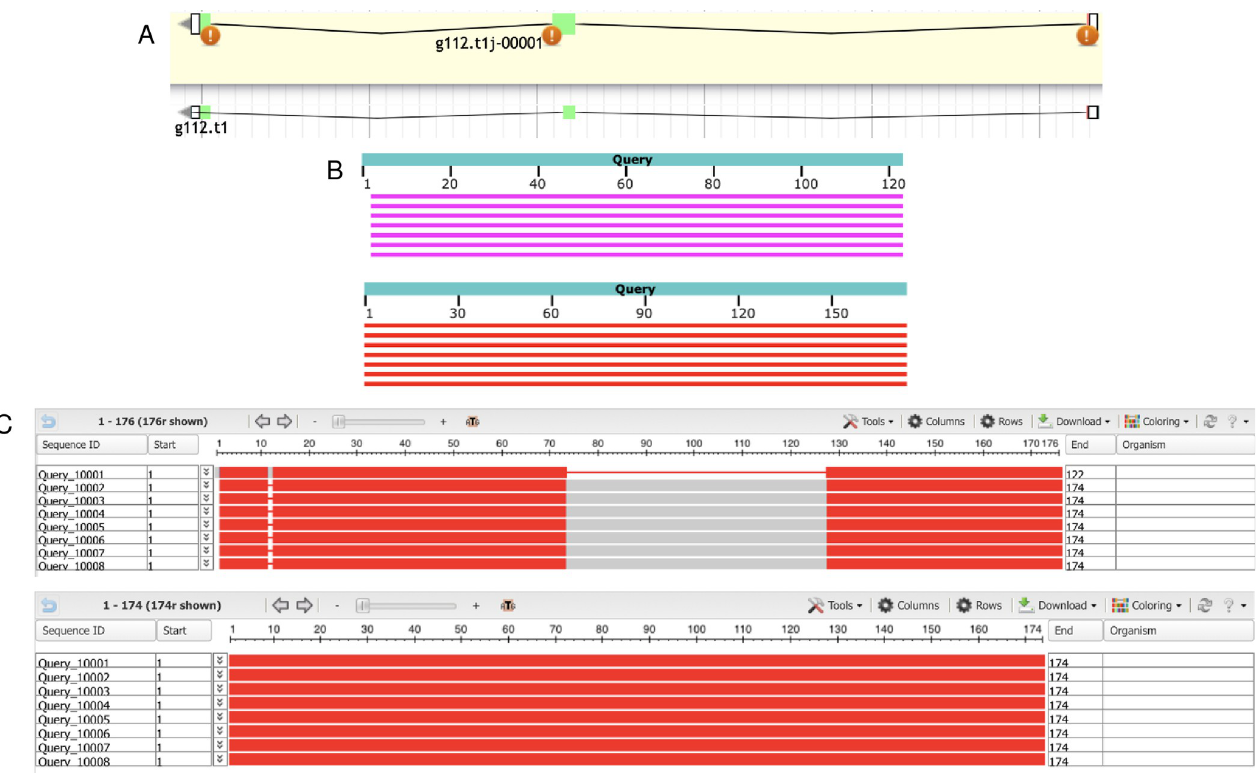
Fig 5. Homology-based genome annotation of the methylmalonyl-CoA epimerase (MCEE) enzyme. (A) Apollo gene editor view and AUGUSTUS track of the g112.t1 gene located within the ML679947.1 scaffold. Bottom: initial ab initio prediction. Top: consensus gene model. (B) Graphical representation of query coverage across the top 7 BLAST hits on 7 subject sequences before (top) and after (bottom) genome editing. Red means high conservation, and magenta means moderate conservation. (C) COBALT multiple sequence alignment before (top) and after (bottom) genome editing, demonstrating high conservation (red) across the homologs. Low conservation is colored gray. Exons (thick lines) and introns (thin lines) are shown. Query sequence is the top, while the subjects are below.